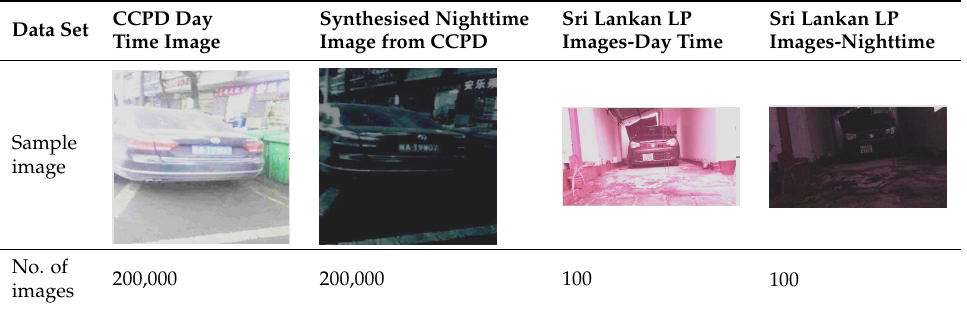
Figure 9. Model Architectures ( left ): hardware-optimized detection, ( middle ): hardware-agnostic detection, ( right ): recognition subnetworks. Table 4. Detailed summary of the data set.